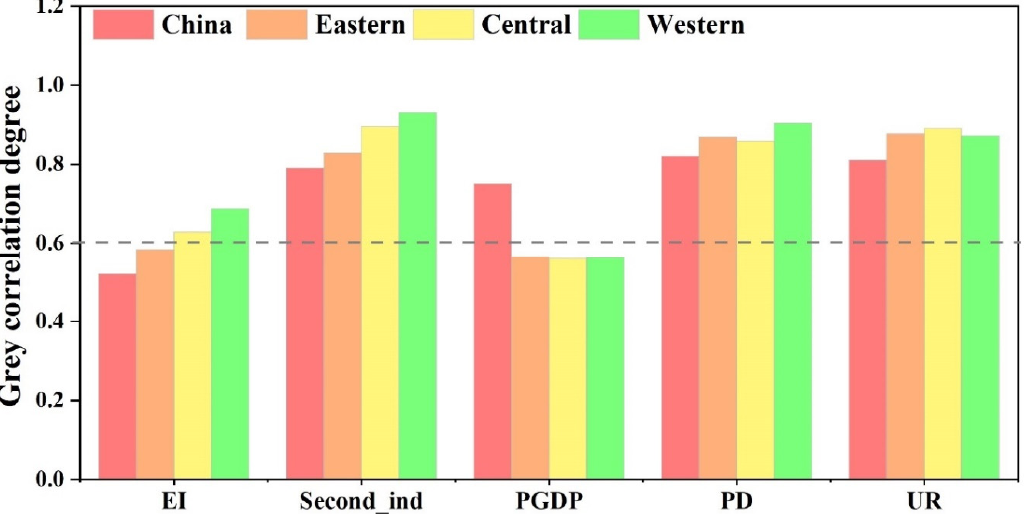
Figure 5. Significance of anthropogenic PM 2.5 concentrations in China during 1998–2016.